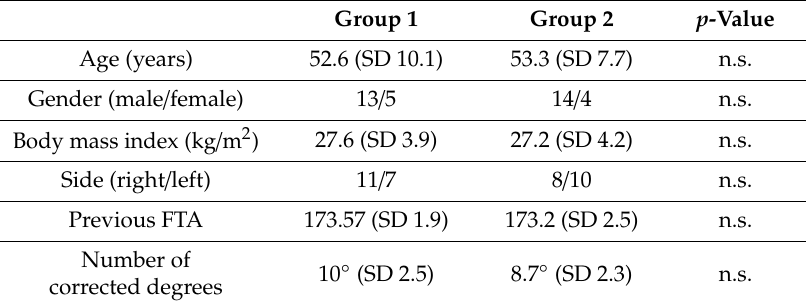
Figure 1. Fibula head osteotomy ( a ) and tibiofibular joint dislocation ( b ). Table 1. Demographic data, preoperative femorotibial (FT) angle and number of corrected degrees in both groups. Not significant (n.s.)